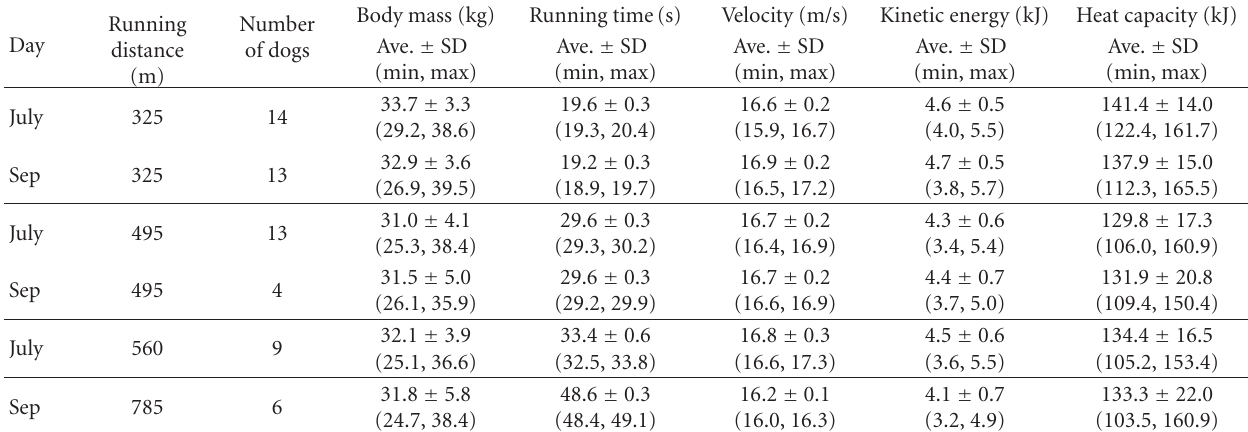
Table 2: Data on the races as well as energy and heat capacity calculations for each dog, distance and race